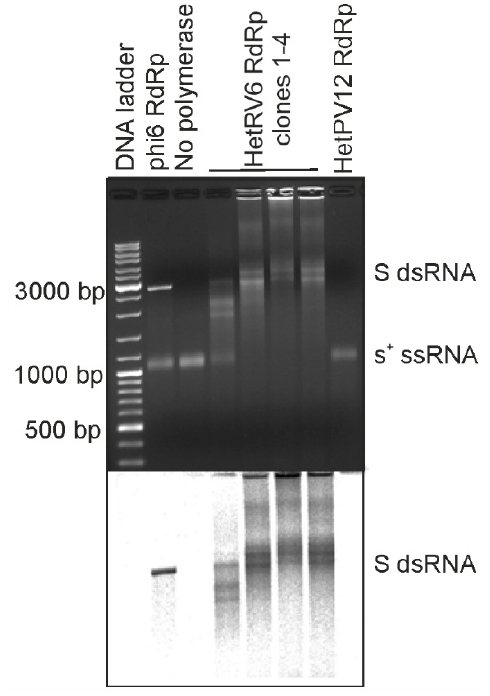
Figure 1. RNA synthesis directed by N-terminally His-tagged HetRV6 RdRp on phi6-specific tem- plate. Four different batches of N-terminally His-tagged HetRV6 RdRp were tested (clones 1–4) as well as similarly purified fractions from E. coli expression of N-terminally His-tagged HetPV12 RdRp. Full-length (+)RNA originating from the S genome segment of bacteriophage phi6 (s + ) was used as a template. As a positive control, RdRp from bacteriophage phi6 was used. The reaction products were analyzed by native agarose gel electrophoresis using 0.8% agarose gel (top). The produced radiolabeled RNA molecules are visualized by autoradiography (below). The lengths of selected DNA ladder fragments are indicated on the left. The mobility of the template ssRNA and the dsRNA product are indicated on the right.